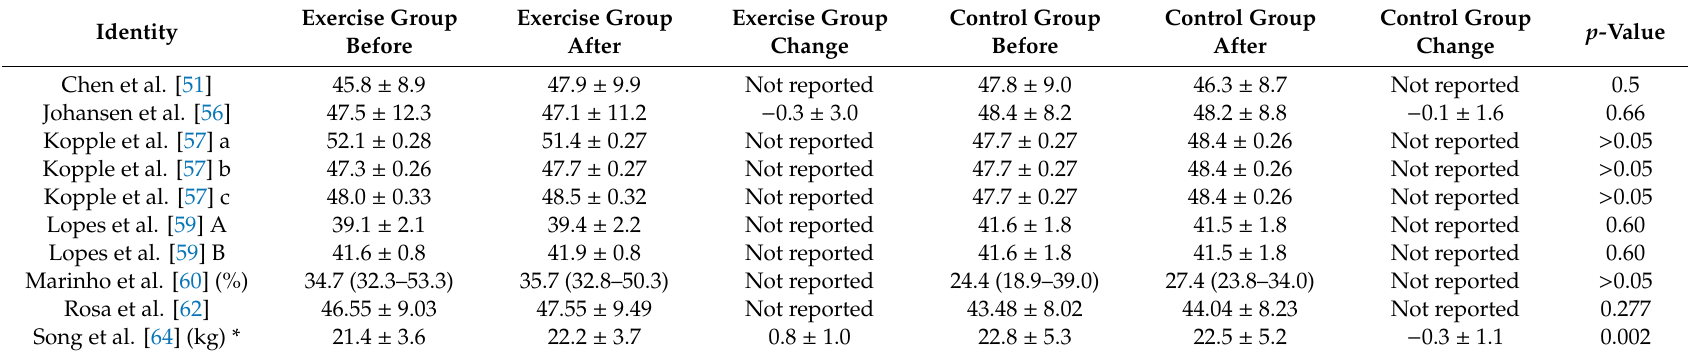
Table 5. E ff ects on Lean Body Mass (kg).